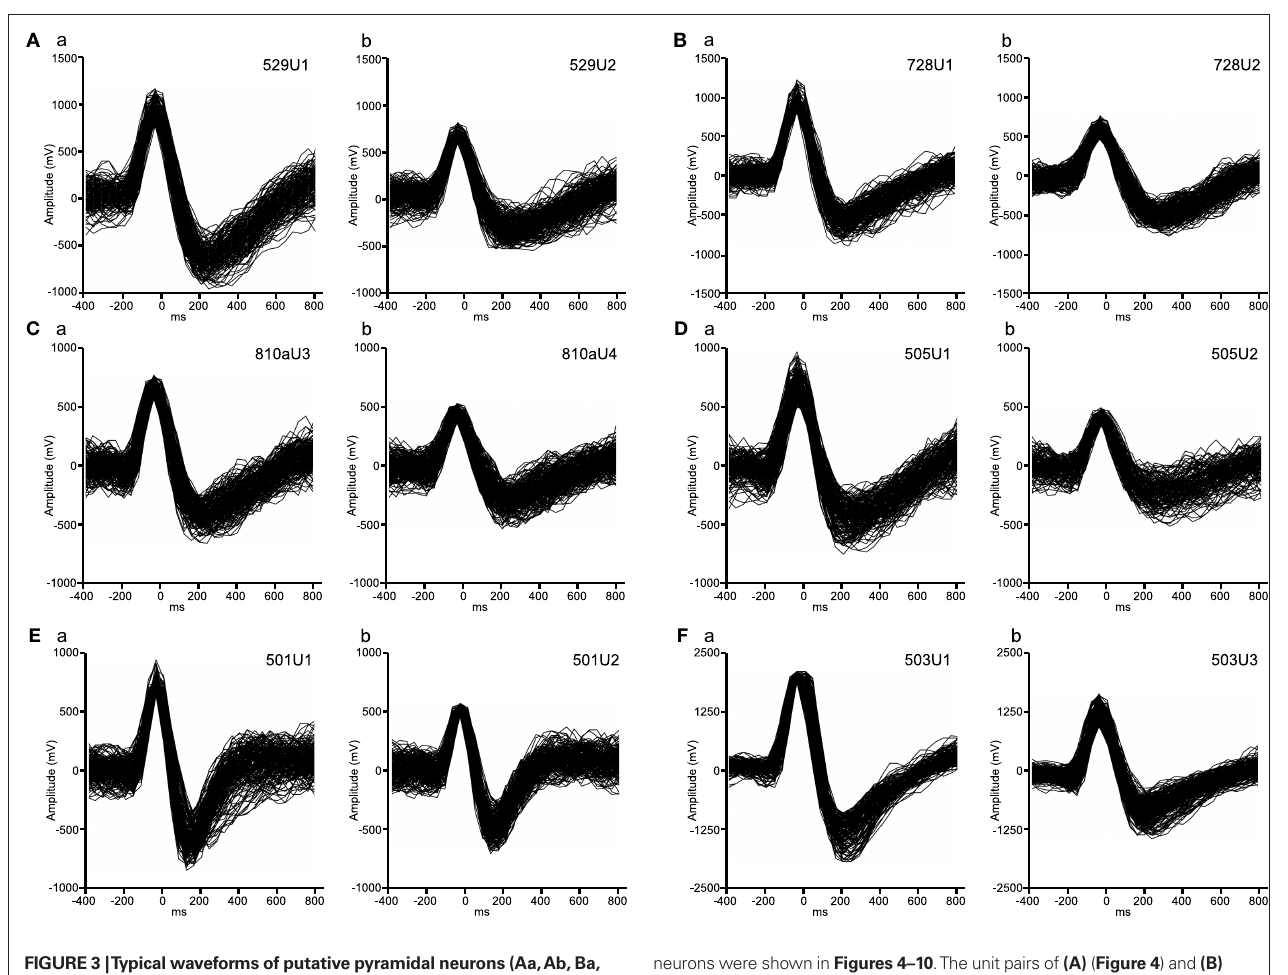
neurons were shown in Figures 4–10 . The unit pairs of (A) ( Figure 4 ) and (B) ( Figure 5 ) show task-dependent CCRs, whereas the unit pairs of (C) ( Figure 6 ), (D) ( Figure 7 ), and (e) ( Figure 8 ) show task-independent CCRs. The unit pair (F) ( Figure 10 ) shows task-dependent CCG peak with